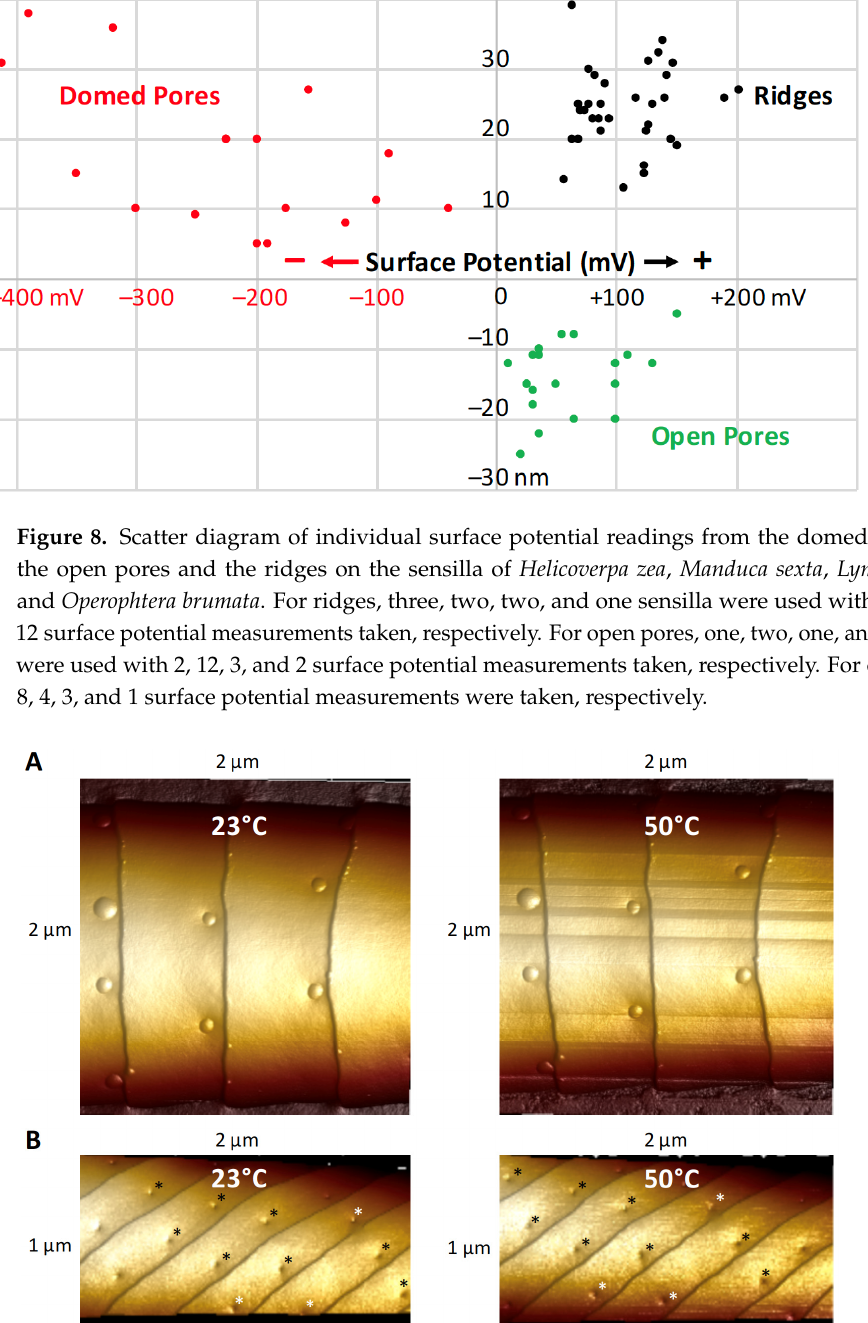
Figure 8. Scatter diagram of individual surface potential readings from the domed pore domes, the open pores and the ridges on the sensilla of Helicoverpa zea , Manduca sexta , Lymantria dispar and